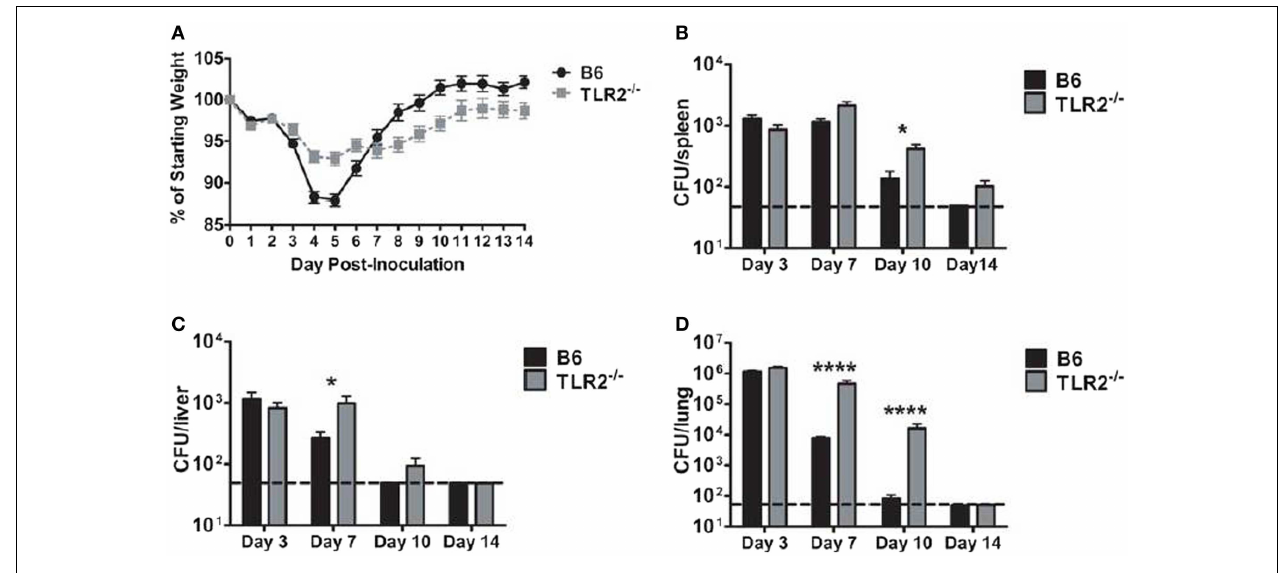
(B) spleen, (C) liver, and (D) lung.The dashed line indicates the limit of detection of 50CFU per organ. Data are combined from two experiments per time point. n = 7–10 mice/group. Bacterial burdens were log transformed and then a Student’s t -test was used to determine statistical